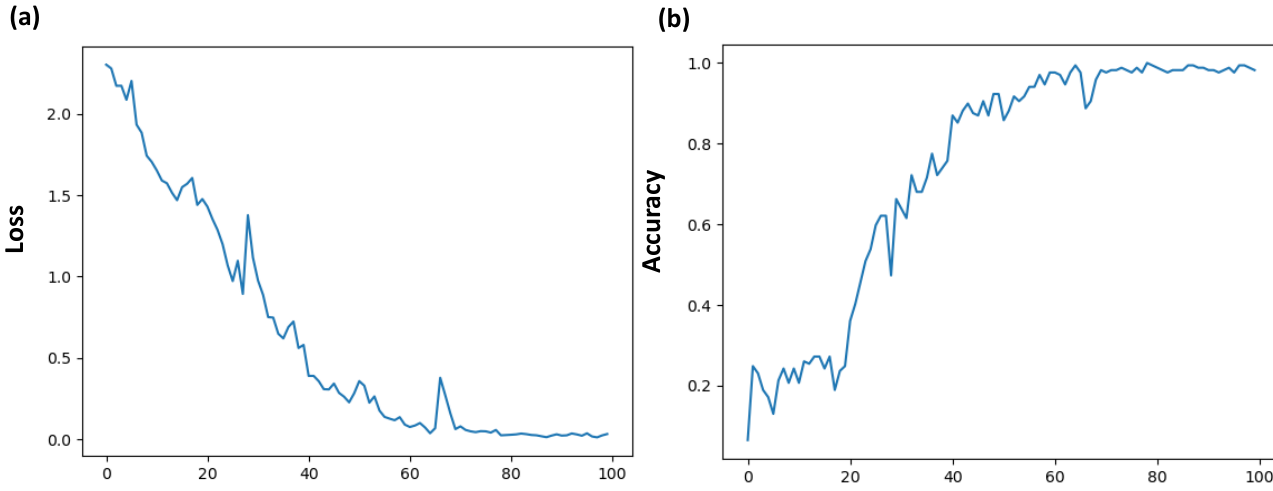
Figure 13. LSTM performance of the training phase for a dataset of 200 web pages: ( a ) Loss trend versus epoch number. ( b ) Accuracy trend versus epoch number.